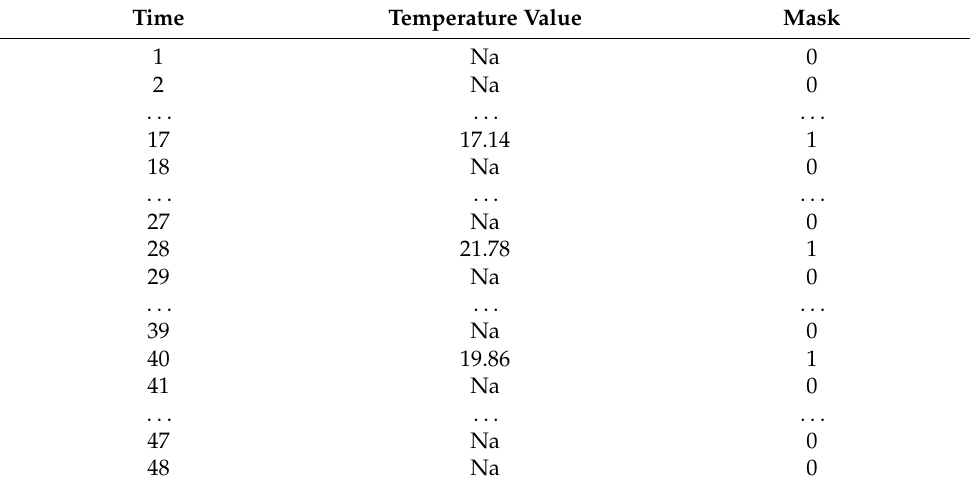
Table 2. Example of data for a day within the window of missing values in the sample series.